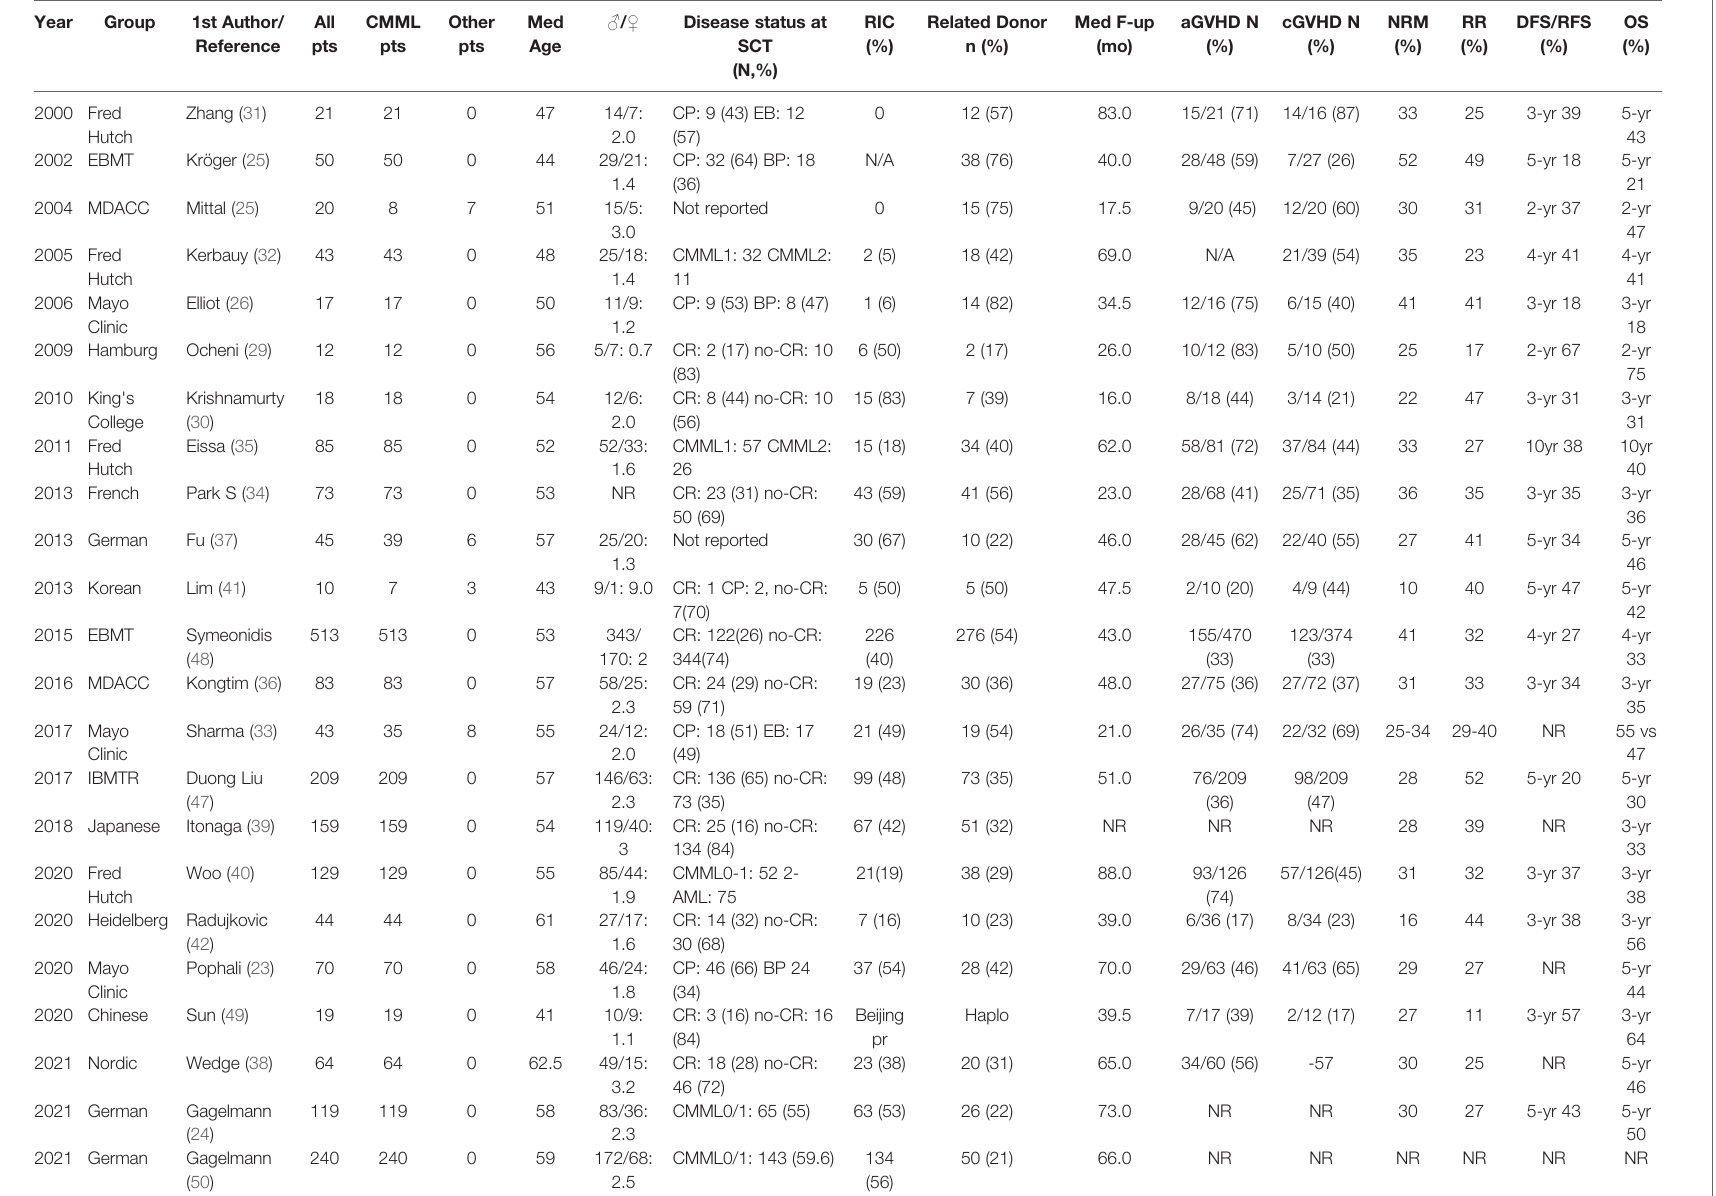
TABLE 1 | Published retrospective studies reporting transplantation outcomes on